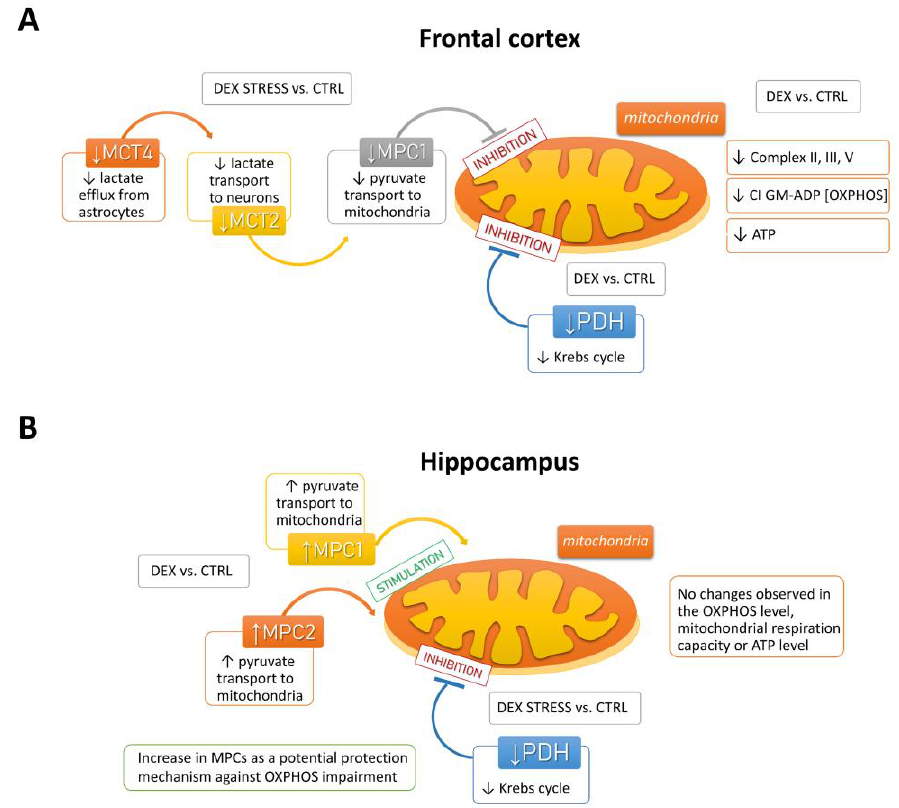
Figure 12. Scheme summarizing the effect of DEX and DEX stress on the dysregulation of energy production in the frontal cortex ( A ) and hippocampus ( B ).